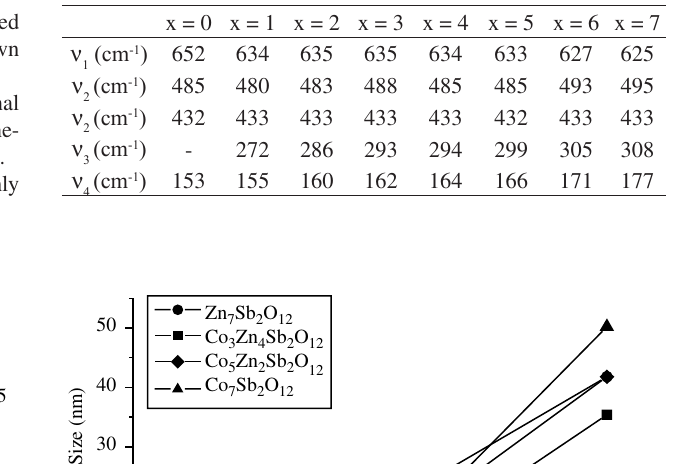
Table 3. Vibrational frequency bands of the samples Co calcined at 1000